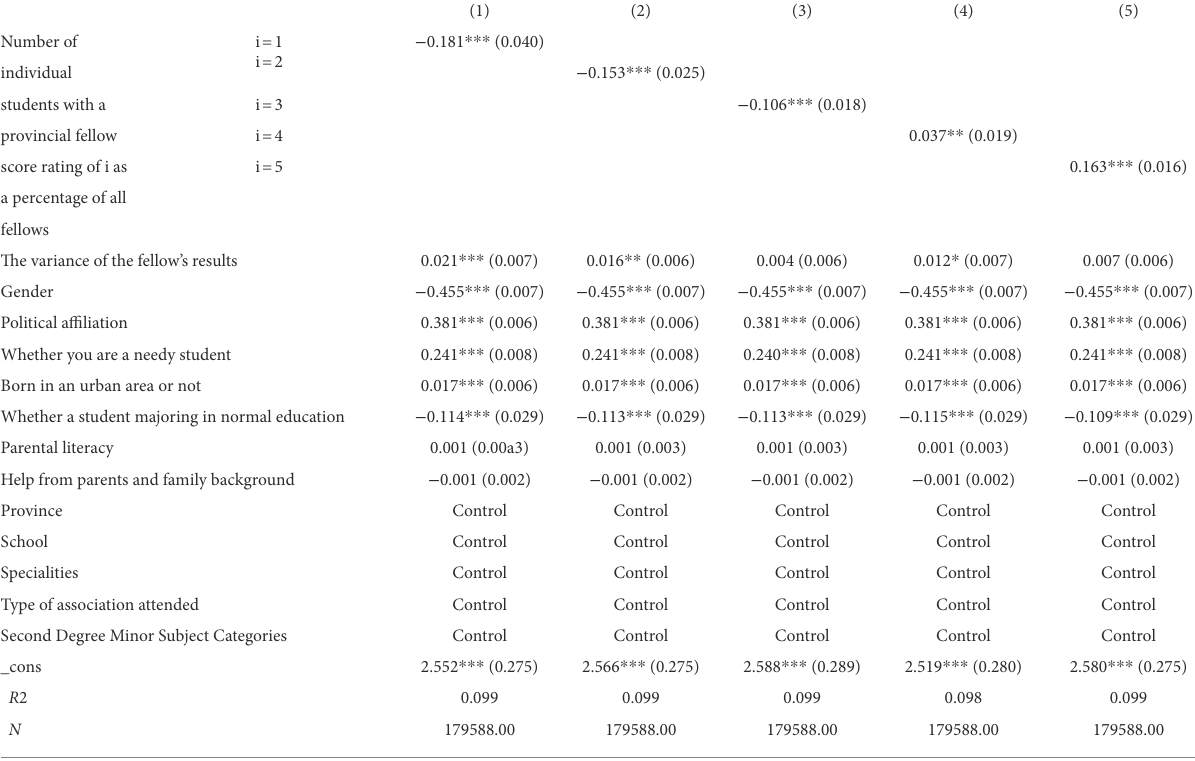
TABLE 3 Regression results for the effect of the fellow effect on academic